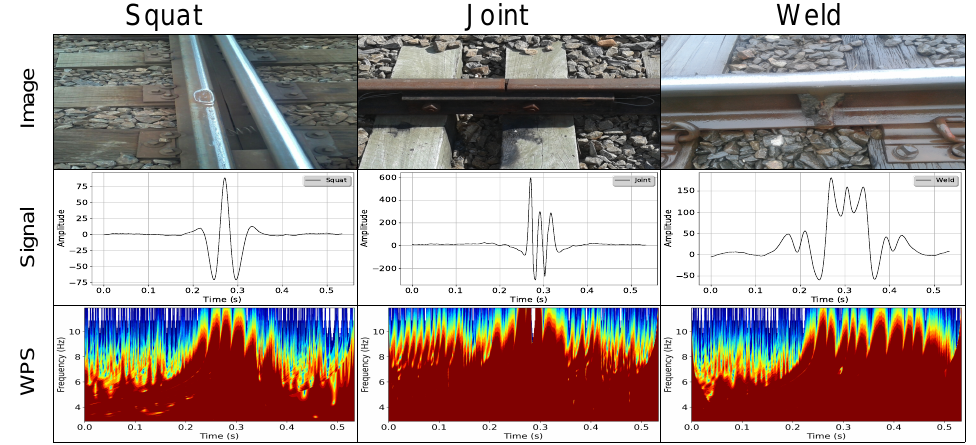
Figure 12. Characteristics of the anomalies considered in this work: squat ( left ), joint ( middle ) and weld ( right ). From top to bottom: picture of the anomaly, the EC acquired signal mean over the training data set and the WPS of the mean signal.